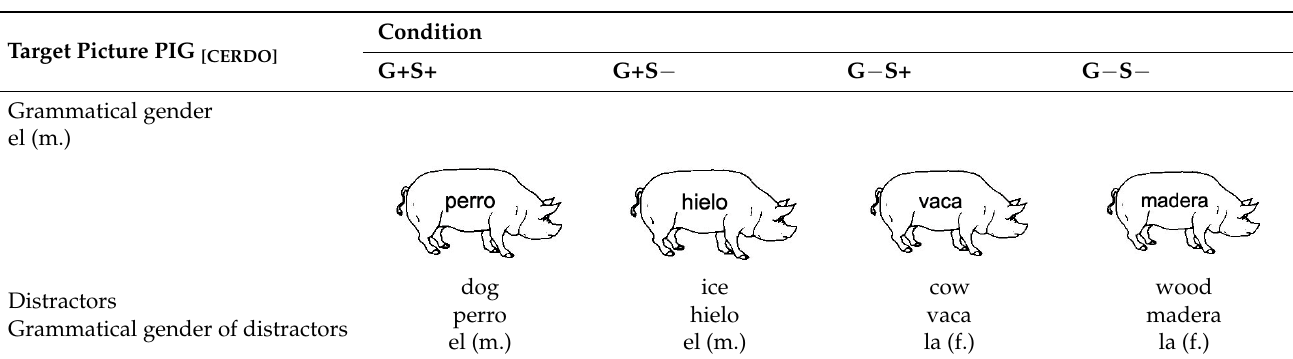
Table 1. Sample of stimuli in the experimental session for the PWI task.